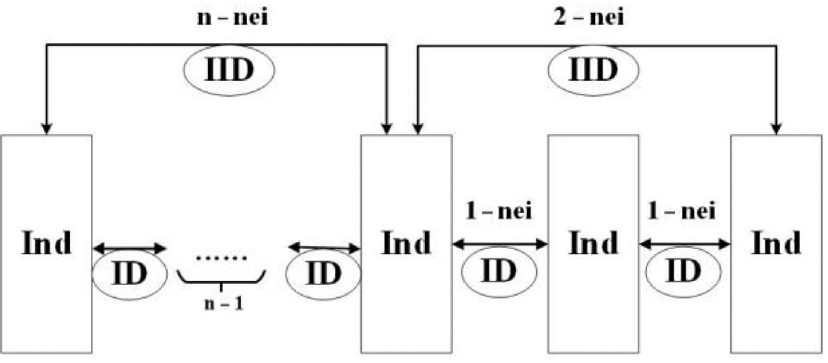
Figure 2. Neighbor interaction pattern